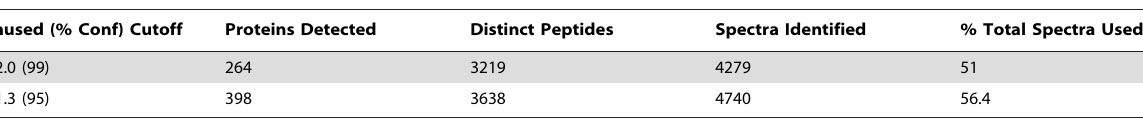
Table 1. MudPIT summary data.